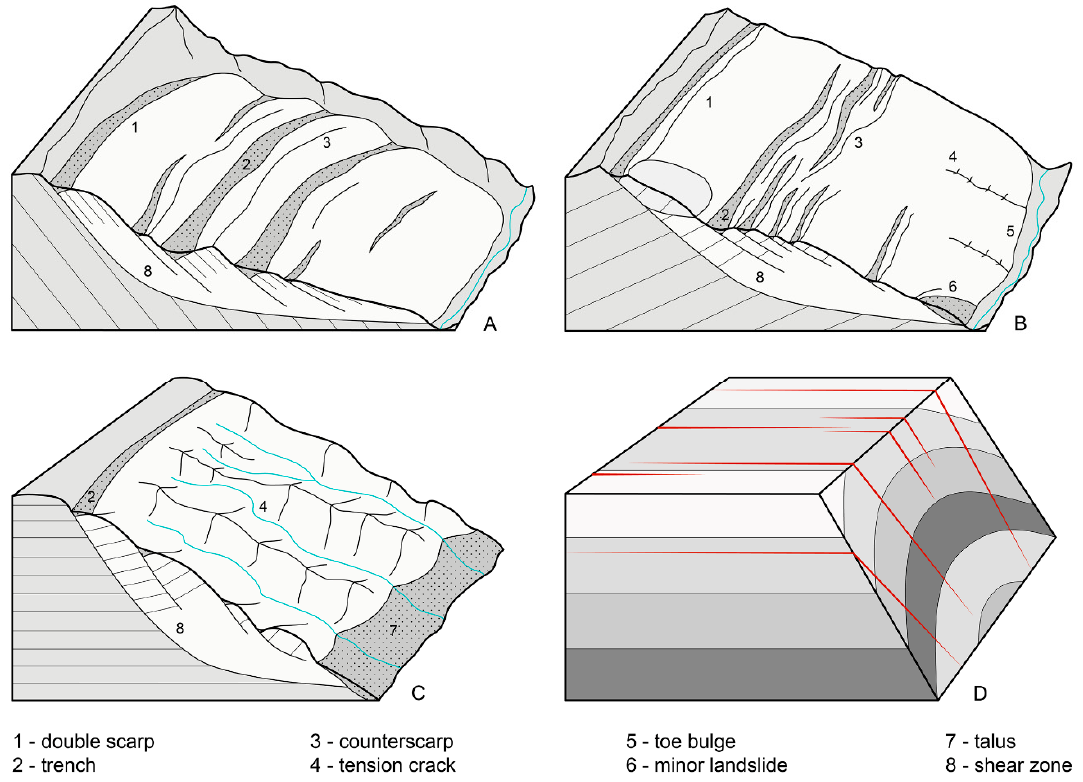
Figure 7. Theoretical models illustrating the development of surface geomorphological features of DSGSDs in relation to lithostructural settings: ( A ) DSGSD along a cataclinal slope; ( B ) DSGSD along an anaclinal slope; ( C ) DSGSD along horizontal strata at a fold hinge; ( D ) scheme of fractures associated with the fold hinge. The scale of the models is in the order of magnitude of the hundreds of metres.